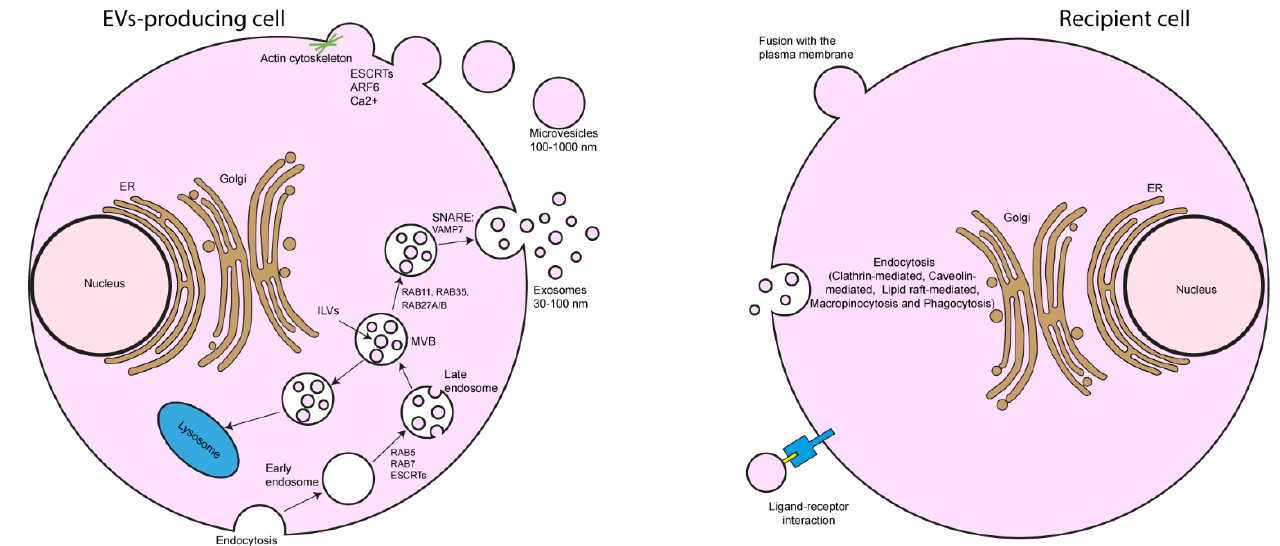
Figure 1. Biogenesis-uptake of EVs. Exosomes are generated through the endocytic pathway by forming an early endosome that matures to produce a late endosome or MVB. Upon budding at its endosomal membrane, it can originate small vesicles called intraluminal vesicles. This can be driven for degradation in the lysosome or interact with the cell plasma membrane to fuse, allowing the release of exosomes (30–100 nm) into the extracellular medium. Microvesicles (100–1000 nm) are released by direct gemination from the cell plasma membrane. Once EVs are released into the extracellular medium, they can interact with a recipient cell through various mechanisms, including direct fusion with the plasma membrane, ligand–receptor interaction, and endocytosis processes including clathrin, caveolin, and lipid raft-mediated endocytosis, micropinocytosis, and phagocy- tosis.